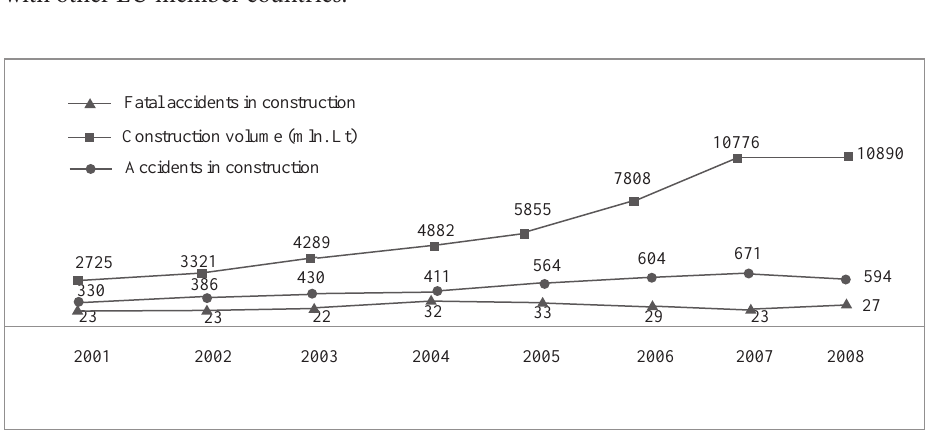
Fig. 2. Trends in construction work volumes and accidents at work in